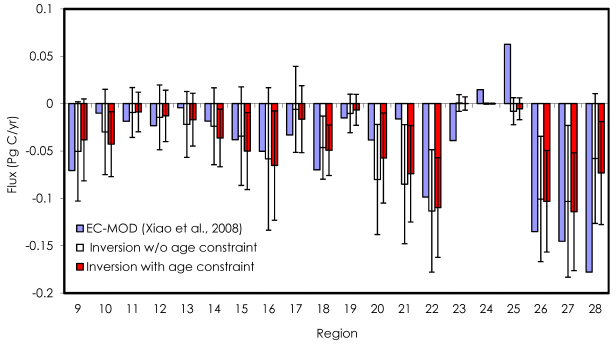
Fig. 4. CO 2 fluxes and uncertainties for 20 North America regions (region 9 to 28) estimated from three different approaches: blue solid square – the EC-MOD method (Xiao et al., 2008), and no un- certainty information is available; empty square – inversion method without age constraint; red solid square – inversion method with age